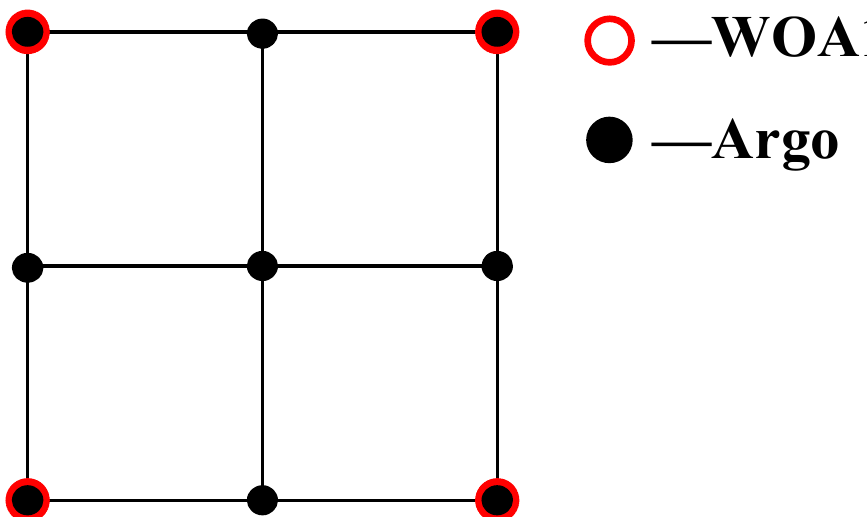
Figure 1. Diagrammatic sketch of a 2° × 2° grid. The hollow red circle represents the climatological SSP derived from T/S in WOA18, and the black dot represents the Argo SSP derived from T/S in BOA_Argo 2018 dataset.